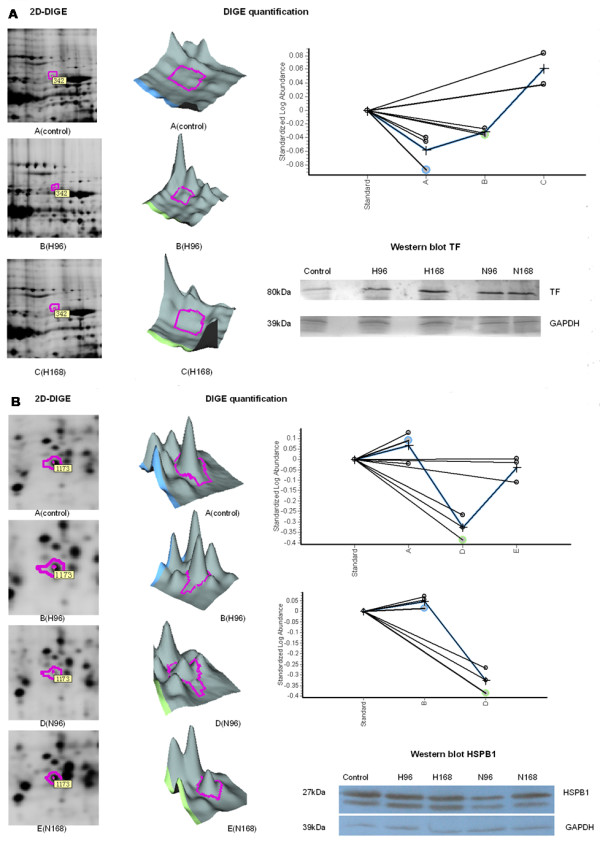
Expression analyses of selected proteins using DeCyder software and western blot validation. A) Representative 2D-DIGE image, quantification, and western blot confirmation of TF in H-PRRSV infected pigs. The standard abundance of the different spots (y-axis) is also shown for the three different experimental conditions: A (control), B (H96), C (H168) (x-axis). Equal amounts of total protein, as shown for GAPDH, were loaded for Western blotting analysis; B) Representative 2D-DIGE image, quantification, and western blot confirmation of HSPB1 in N-PRRSV infected pigs and those between N-PRRSV vs. H-PRRSV. The standard abundance of the different spots (y-axis) is also shown for different experimental conditions: A (control), D (N96), E (N168), B (H96) (x-axis). Equal amounts of total protein, as shown for GAPDH, were loaded for Western blotting analysis.